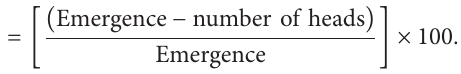
Table 2: Initial soil pH values of each trial-location and amount of hydrated lime and aluminum sulfate required to change soil pH by 1.0